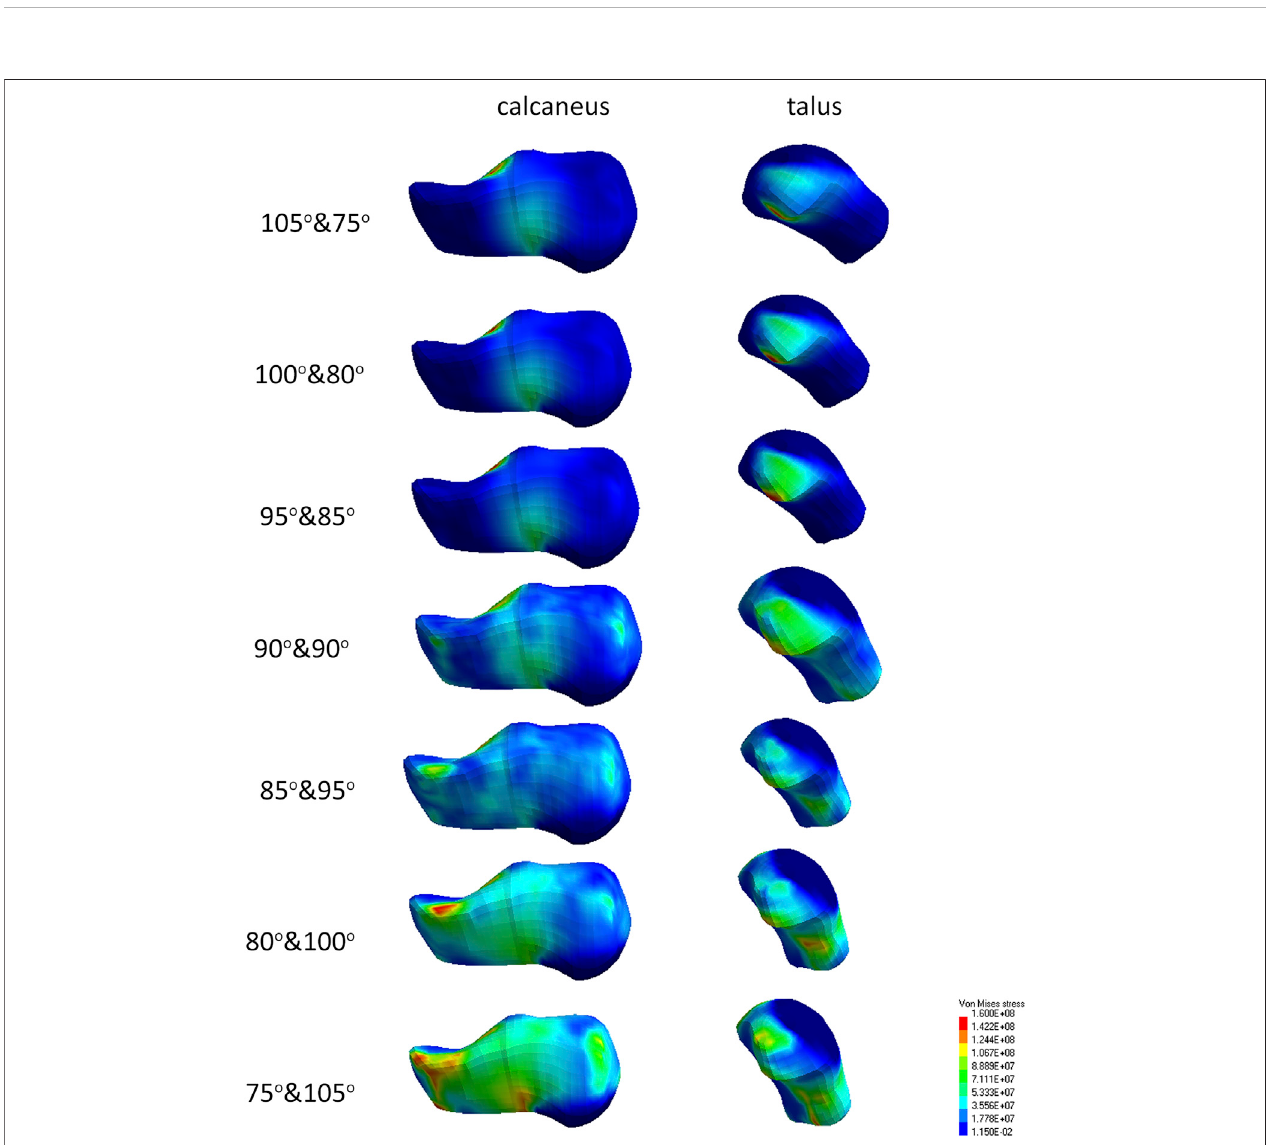
FIGURE 7 | Stress fi eld maps of tallus and calcaneus for different